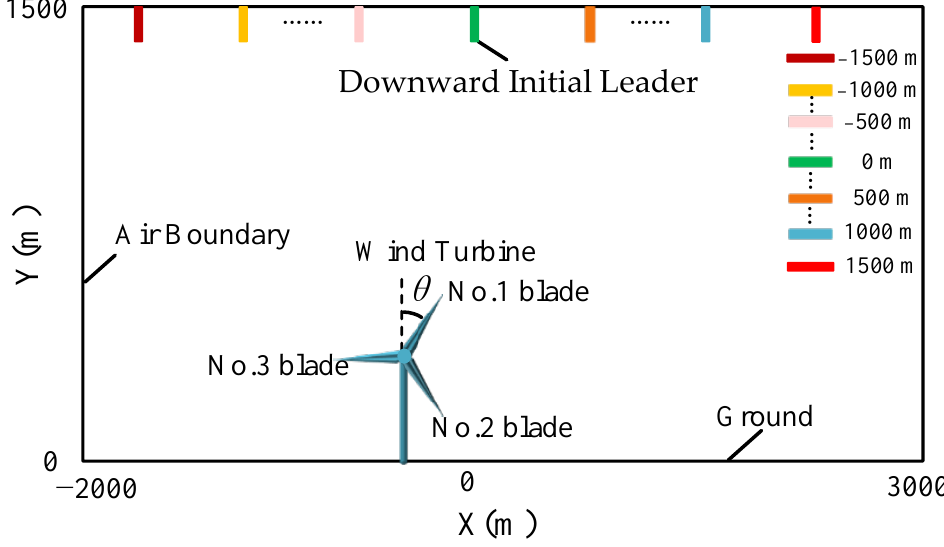
Figure 3. Spatial schematic diagram of the simulations. The actual process of lightning striking a wind turbine is not the process of lightning directly attachment to the wind turbine, but the connection of UL and DL initiated from the wind turbine. That is, the accuracy of evaluating the lightning striking performance with the traditional concept of striking distance is questionable. In this research, based on the SLM, the distance between the point of the wind turbine, where a connecting leader is initiated, and the heads of DL when the final jump condition is established between the connecting leader and the DL, is defined as striking distance (as shown in Figure 4). The striking distance changes with different blade angles and tower heights, and it not only can clarify the physical meaning of the striking distance but can also adapt to the complex mechanical structure and rotating characteristics of turbine blades. According to the Monte Carlo idea, the striking distance should be derived from a large number of simulation tests. Therefore, the cases of lightning flashes with various lightning current striking to the different heights of wind turbines are simulated. In diverse cases, 400 simulation tests are performed for each lateral distance (from − 1500 m to 1500 m). There is a total of 8000 simulation results for each case. The value of the striking distance for each case is the arithmetic mean of the simulation results when the lightning strikes to the wind turbine